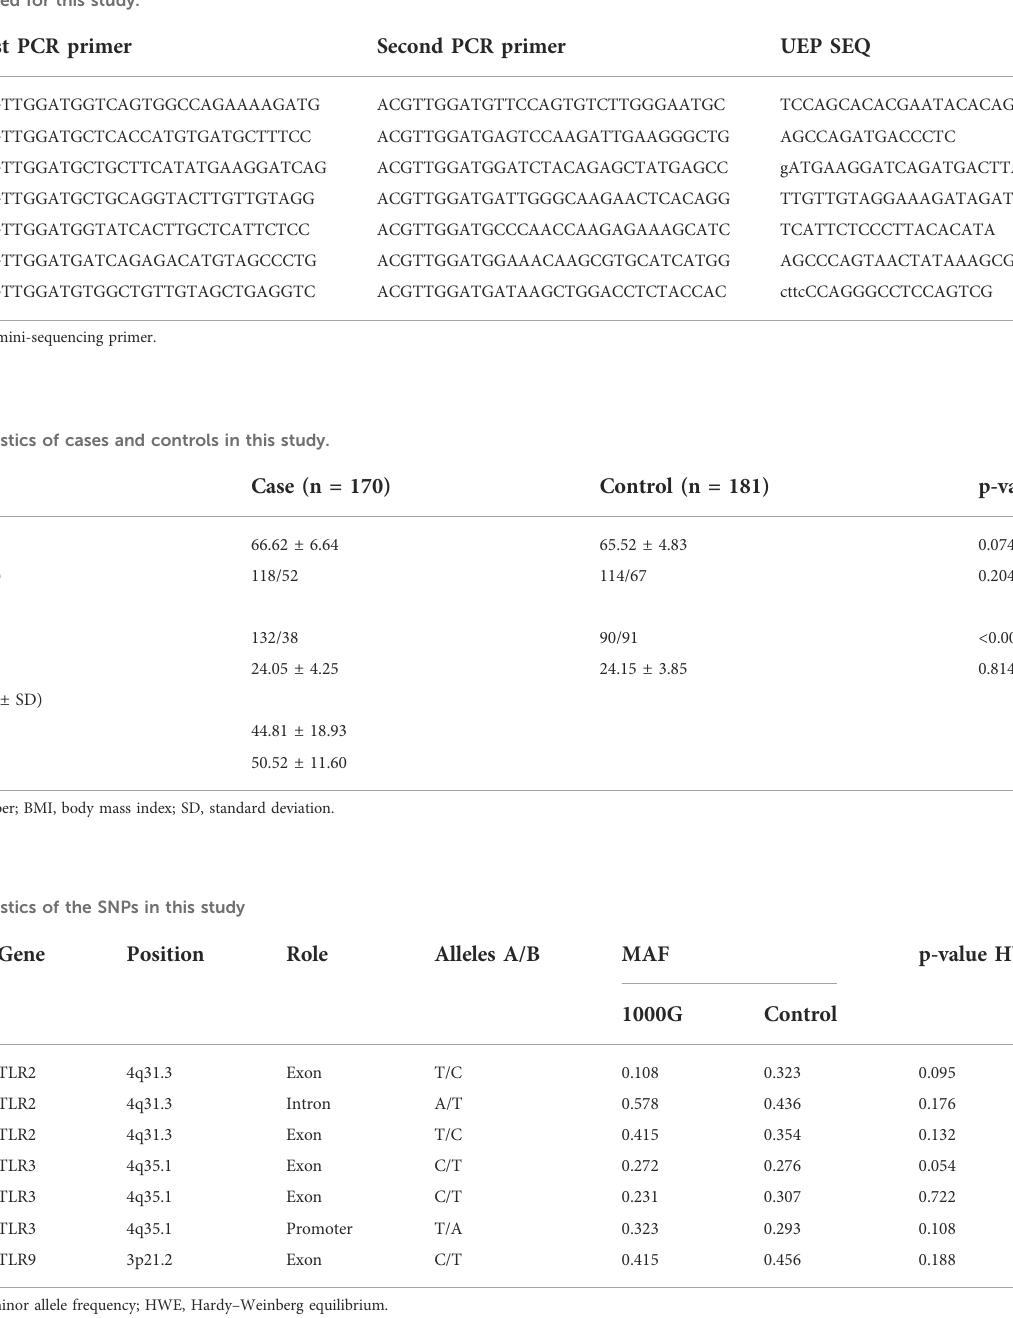
TABLE 1 Primers used for this study.